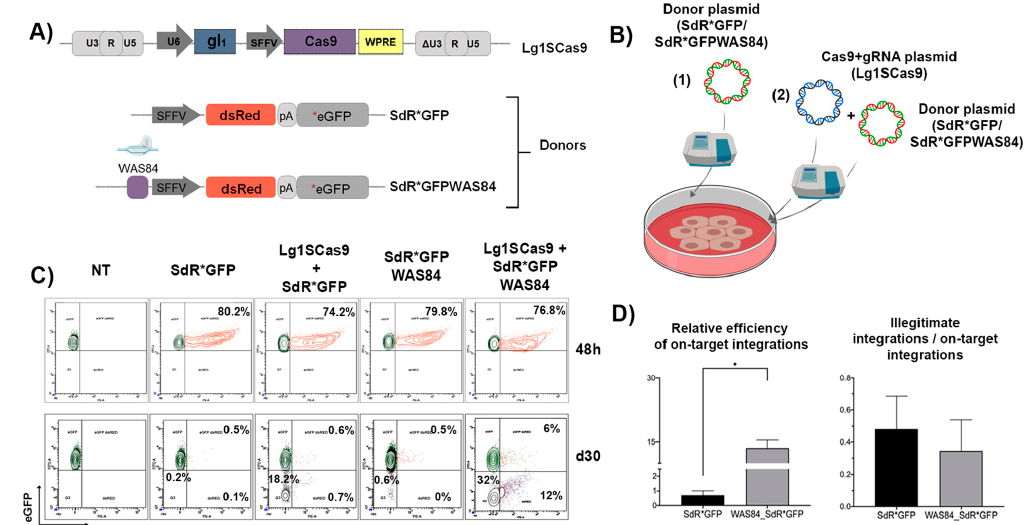
Figure 2. Inclusion of the target sequence into the donor template increases the e ffi ciency of on-target donor integration without increasing illegitimate integrations in K562 SEWAS84. ( A ) Scheme of CRISPR / Cas9 lentiviral plasmid expressing Cas9 and the gRNA (See M&M for details) (top) and di ff erent DNA donors (bottom): SdR*GFP donor (previously describe) and SdR*GFPWAS84 donor harbouring the CRISPR / Cas9 target site. ( B ) Drawing of the delivery methods used for the di ff erent donors (SdR*GFP donor or SdR*GFPWAS84) and the CRISPR / Cas9 system (Lg1SCas9) used alone as controls (1) and with the CRISPR / Cas9 system (Lg1SCas9) (2). Both systems were delivered to the target cells as plasmids by nucleofection. ( C ) Representative plots showing eGFP (FITC-A) and dsRED (PE-A) expression 48 h (top) and 30 days (bottom) of K562 SEWAS84 without any treatment (NT) and after nucleofection with donors only (SdR*GFP donor or SdR*GFPWAS84), and with L1SCas9 (all-in-one CRISPR/Cas9 lentiviral plasmid expressing Cas9 and the gRNA. See M&M